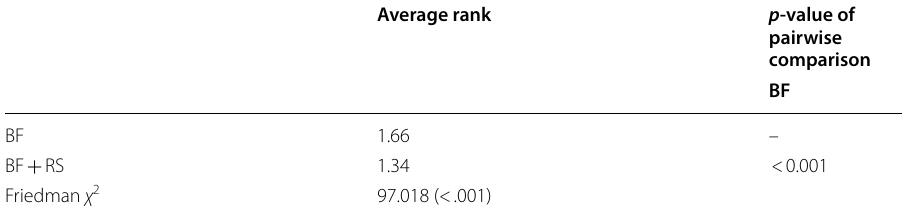
Table 21 Results of pairwise comparison (BF vs. BF